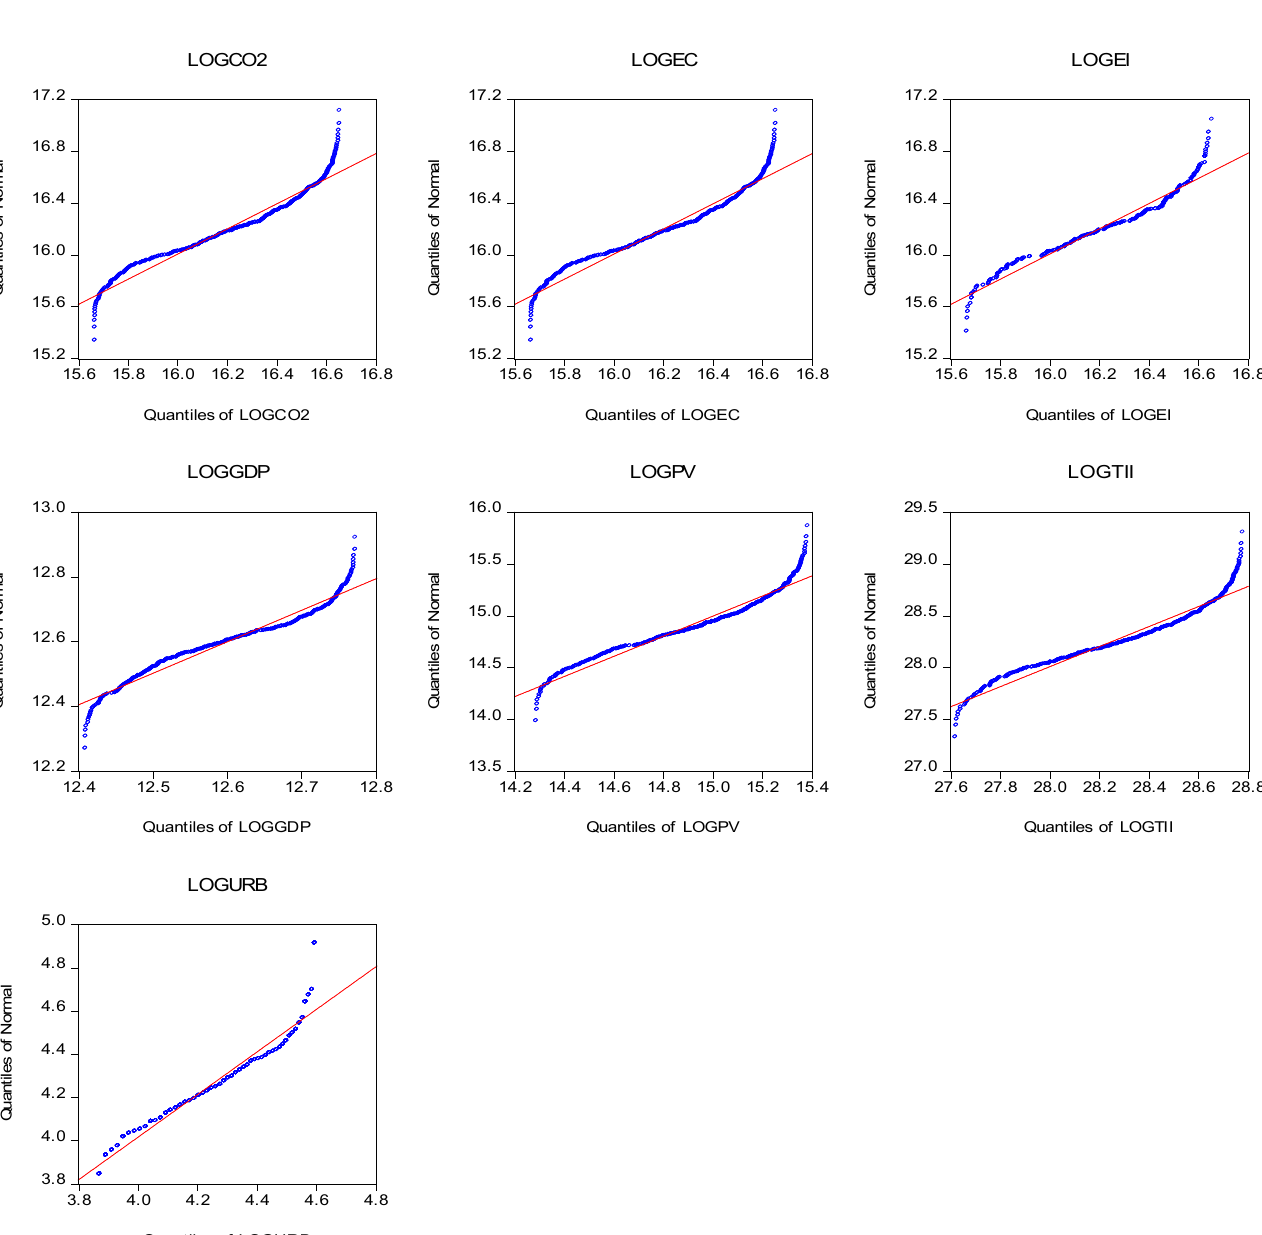
Figure 2. Impact characteristics of trends for carbon emissions with the exogenous variables in the transportation sector of South Africa. Blue incline curves: parametric values of the exogenous; Red linear slope: Conditional boundaries.